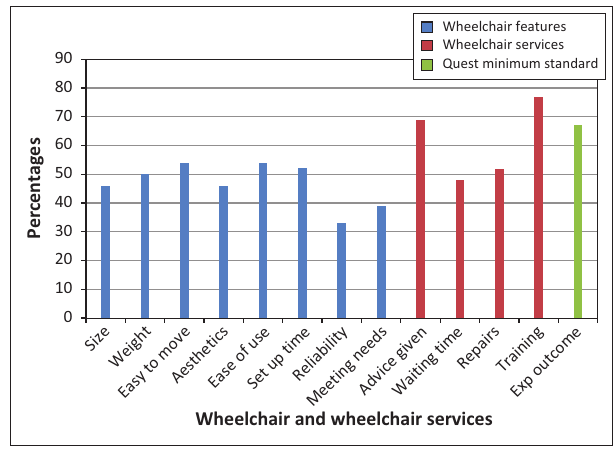
FIGURE 3: Percentage of adult users who were very or quite satisfied with their wheelchair and wheelchair services according to the QUEST 2.0 ( n = 44).